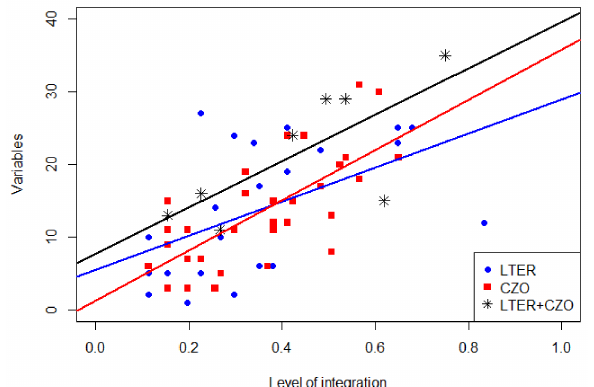
Figure 4. Model-wise “level of integration” calculated from the summed scientific disciplines and modelled compartments for the corresponding model. Trend lines corresponding to the models as- sociated with LTER (blue) and CZO (red), and models associated with data from both networks (black) are